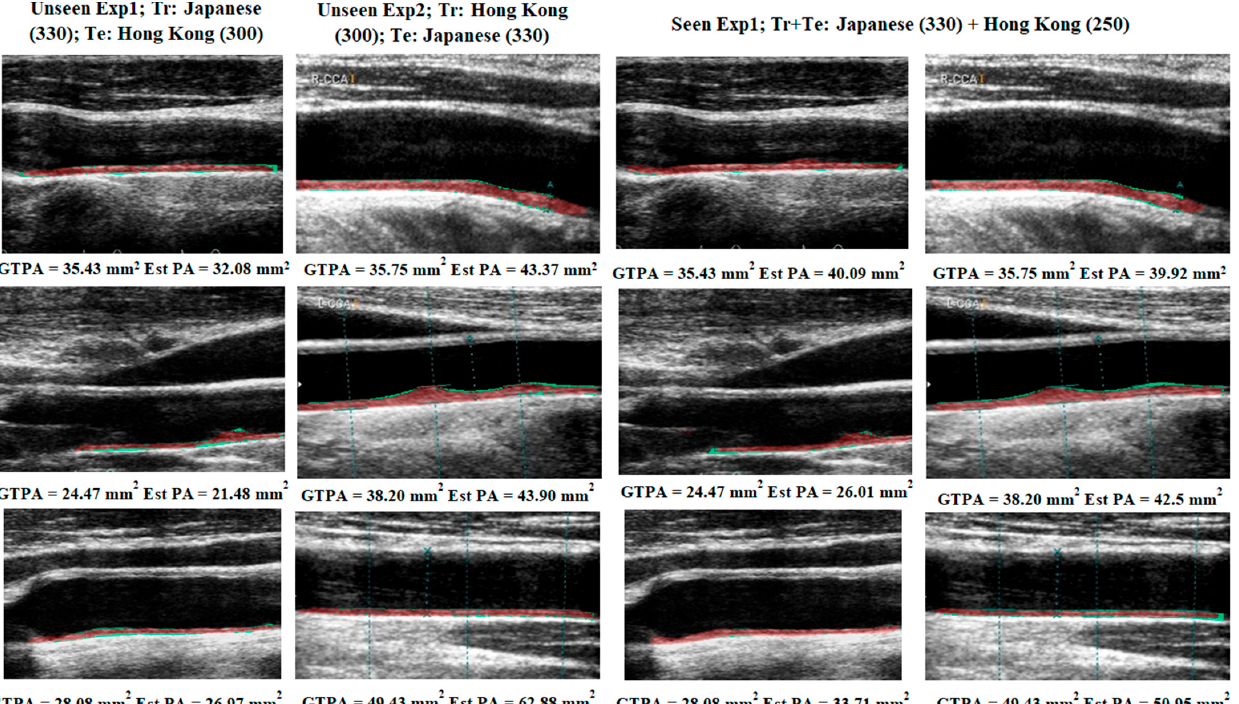
Figure 5. Visual results of the Unseen AI and Seen AI experiments. [Column 1 shows the absolute difference images of the HK test DB for experiment#1 (Unseen AI-1 (Tr: JAP, Te: HK)). Similarly, Column 2 shows the absolute difference images of the Japanese test DB for experiment#2 (Unseen AI-2 (Tr: HK, Te: JAP)). However, columns 3 and 4 represent the difference images from the mixed database of experiment#3 (Seen AI-1 CV w/ Mixed)].